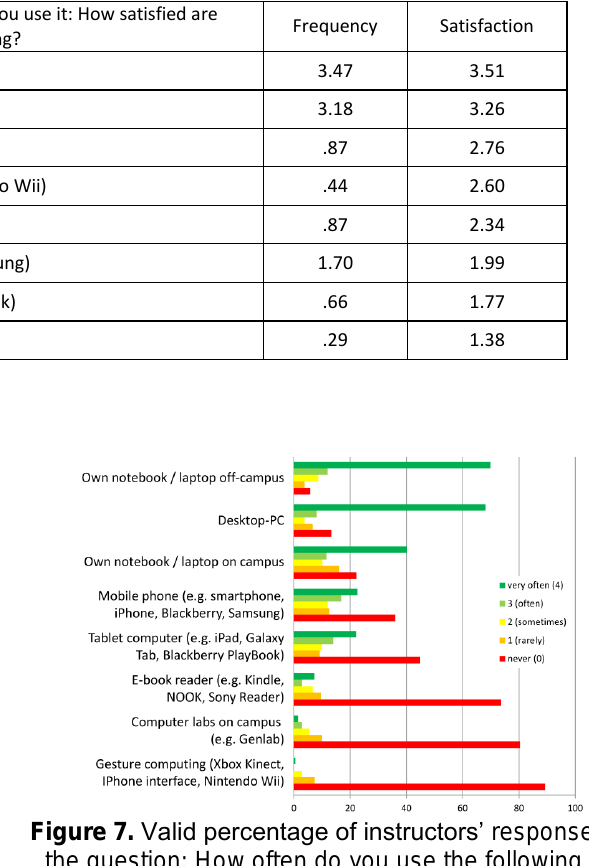
Table 5. Means of studen ts’ answers to the questions: How often do you use the following for learning/studying? and If you use it: How satisfied are you with the use/functionality of the following for learning/studying?